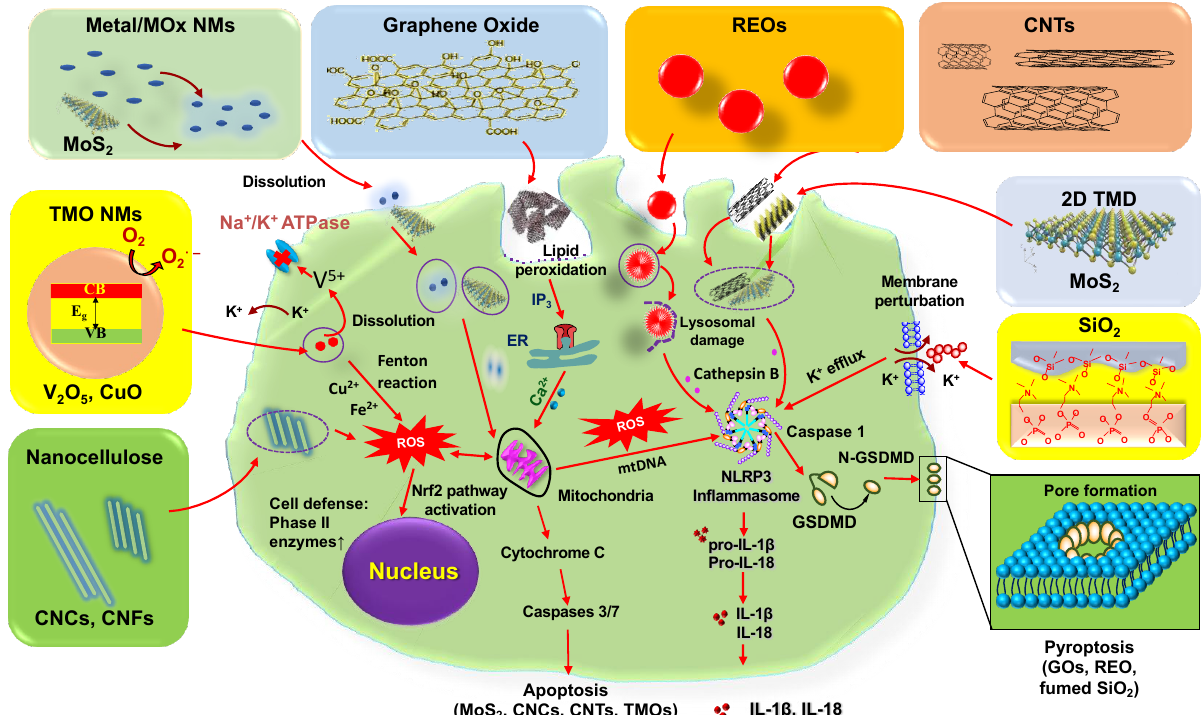
Figure 2. ENMs-induced NLRP3 inflammasome activation in macrophages. This includes the metal or metal oxide (MOx) or transition-metal oxide (TMO) NMs; for example, CuO induces NLRP3 inflammasome activation and apoptosis due to their dissolution and shedding of toxic ions and oxidative stress; REOs (e.g., Gd 2 O 3 , La 2 O 3 , and Y 2 O 3 ) and GOs induce NLRP3 inflammasome dependent pyroptosis in macrophages. For REOs, the transformation from sphere to sea urchin-shaped and the formation of rare-earth phosphate (REPO 4 ) structures on the lysosomal membrane, where RE(III) ions strip phosphate from the phospholipids, induce lysosomal damage, cathepsin B release, leading to NLRP3 inflammasome activation and GSDMD-mediated pyroptosis; the phagocytized GOs-induced NADPH oxidase activation leads to lipid peroxidation, triggering PLC activation that leads to calcium flux, mitochondrial ROS generation, and NLRP3 inflammasome activation, resulting in IL- 1β production as well as subsequent pyroptosis. For fumed SiO 2 , the activation of NLRP3 inflammasome is involved in the pathway premised on K + efflux resulting from the plasma membrane perturbation after SiO 2 binding. Moreover, 2D transition metal dichalcogenides (TMD), CNCs, and CNTs induce ROS-mediated apoptosis and NLRP3 inflammasome-mediated inflammatory responses in macrophages after their internalization. V 2 O 5 sheds V 5+ ions that inhibit Na + /K + ATPase, leading to K + release from constitutive K + channels, which activates NLRP3 inflammasomes.